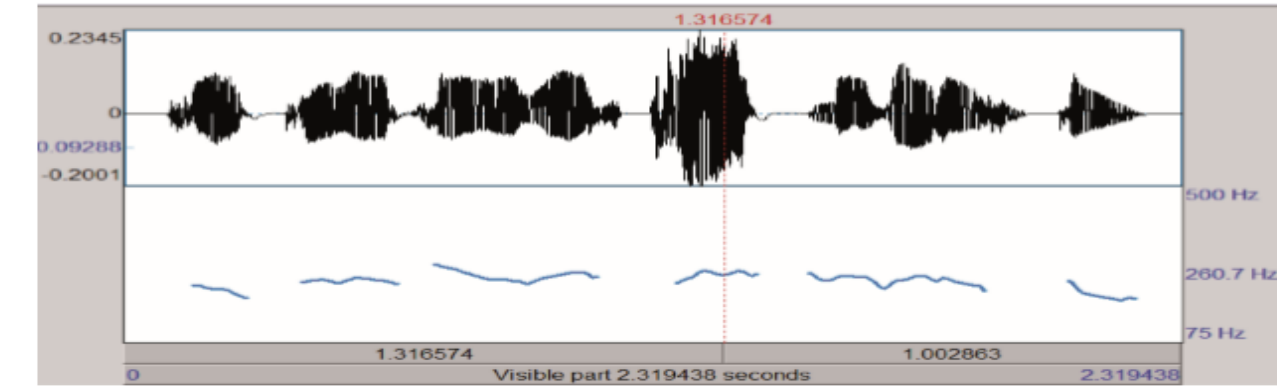
fig.2 Pitch contour for Fear